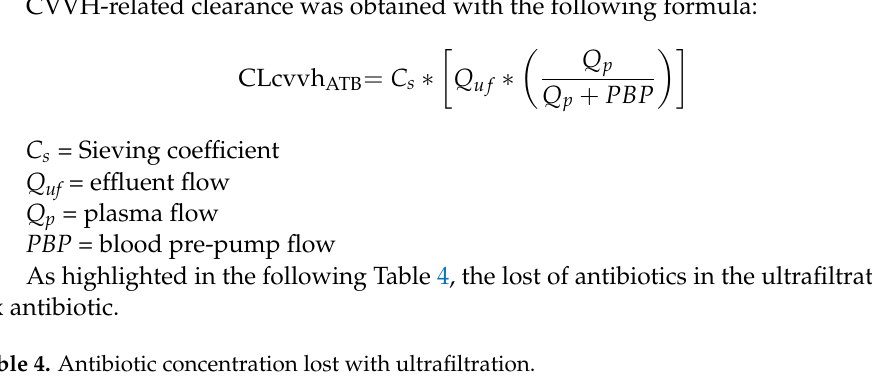
Figure 4. Contribution of antibiotic clearance linked to CVVH in relation with the total body clearance.